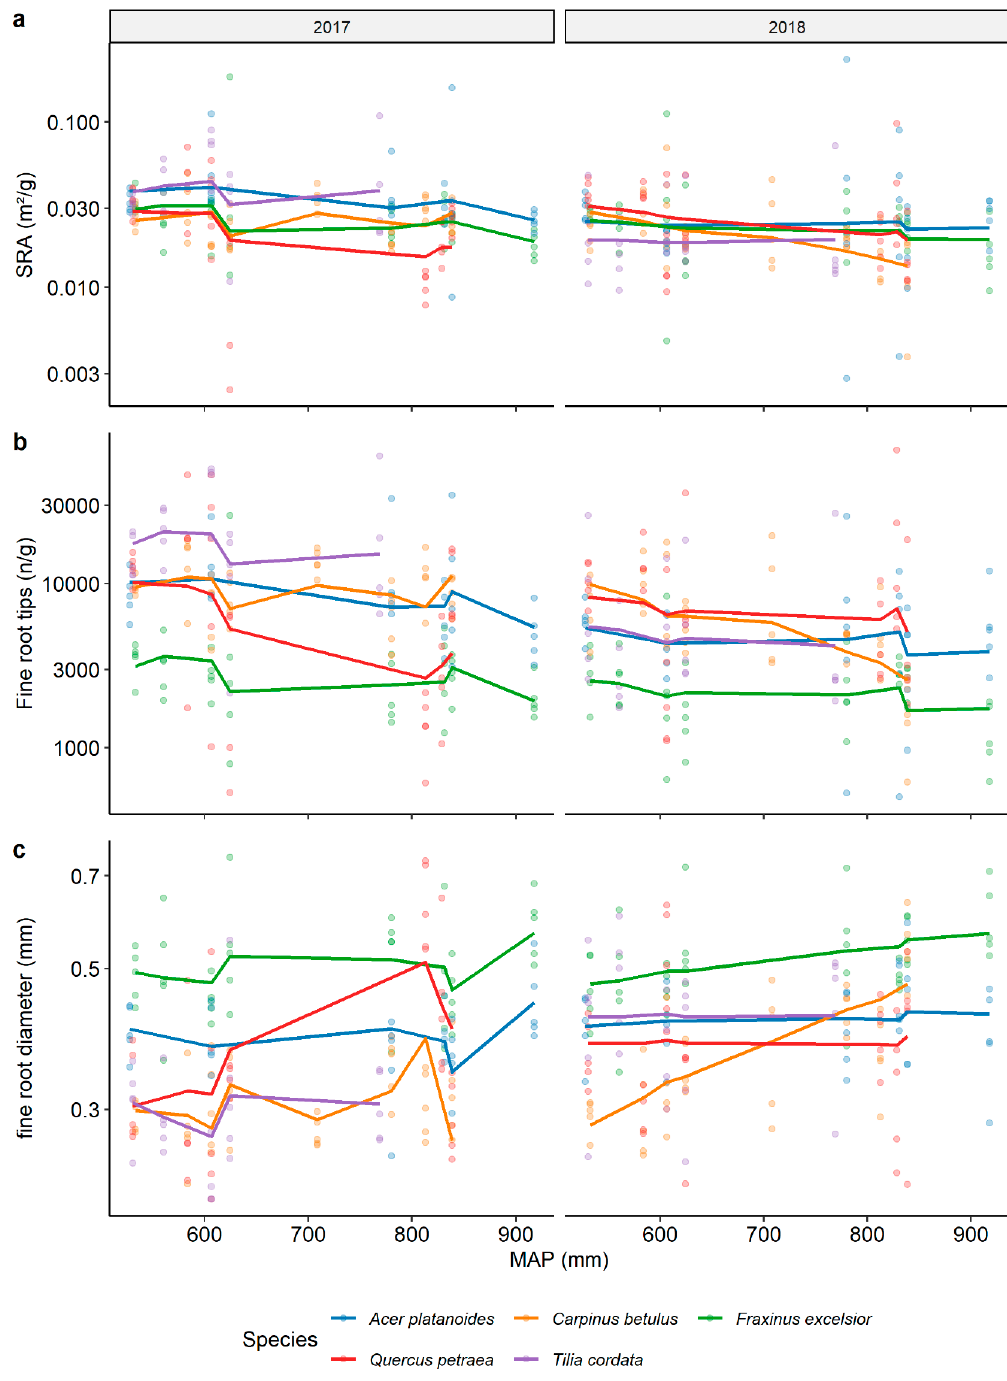
Figure A2. Specific root area ( a ), fine root tips per root mass ( b ), and average fine root diameter ( c ) in the topsoil (0–10 cm) of the five species in relation to mean annual precipitation (MAP) in the 2017 and 2018 inventories. Data points are tree-level values, lines represent conditional predictions of the linear mixed e ff ects model (the predictions of the fixed e ff ect “MAP” for each species plus an intercept for each level of the random factor “site”). Note the log-scaled y-axis. The corresponding p and pseudo- R 2 values are summarized in Table 3.